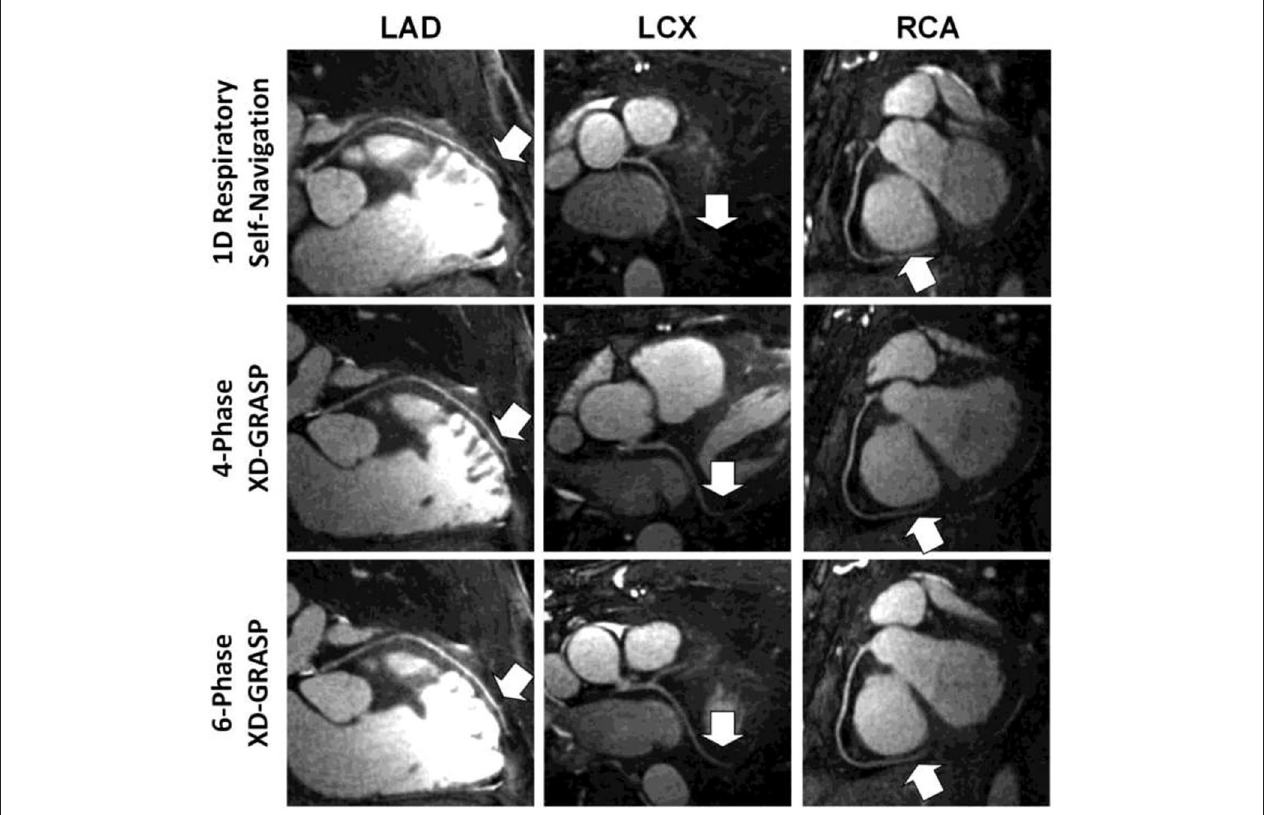
FIGURE 4 | Examples of multiplanar reformatted coronary arteries from one representative healthy adult volunteer. Although respiratory self-navigated reconstruction with 1D motion correction could achieve high image quality (top row), a clear improvement in sharpness as well as visible vessel length (arrows) can be noticed in both four-phase (middle row) and six-phase (bottom row) extradimensional golden-angle radial sparse parallel (XD-GRASP) reconstructions. Adapted with permission from Piccini et al.